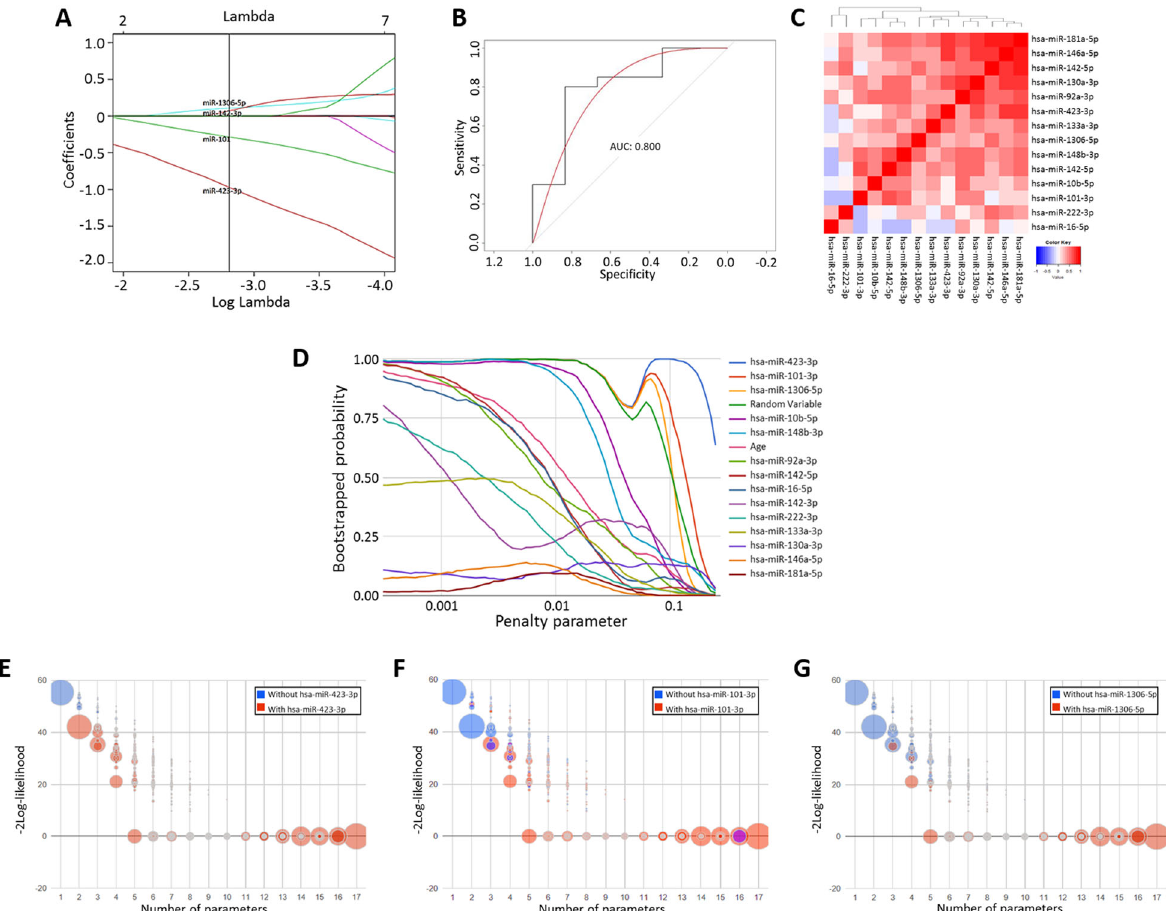
Fig. 6 Performance of the LASSO model used to construct a miRNA signature to diagnose sCJD. A LASSO coef fi cient pro fi les of the 14 miRNAs including age and a random variable generated using the training cohort. Each curve corresponds to a miRNA. The vertical line is drawn at the value λ = 0.0794 chosen by 1000x cross-validation. B Receiver operating characteristic (ROC) curve for the performance of miRNAs and AUC values calculated using the validation set. C Correlation matrix heatmap of the 14 miRNAs from the training cohort, where each cell represents the Pearson correlation between the miRNA indicated in the corresponding row and columns. Dendrograms show the hierarchical clustering of the collinearity of the 14 candidate miRNAs. D The variable inclusion plots that indicate the three most important features above reference variable (RV). E – G Model stability bubble plots representing the stability of the model with the presence and absence of the strongest miRNAs in the model, hsa-miR-423-3p, hsa-miR-101-3p and hsa- miR-1306-5p. Each bubble represents a model and the colour of the bubble indicates whether (red) or not (blue) the model includes the particular miRNA. The size of the bubble corresponds to the probability of the model of the same size obtained from the ×1000